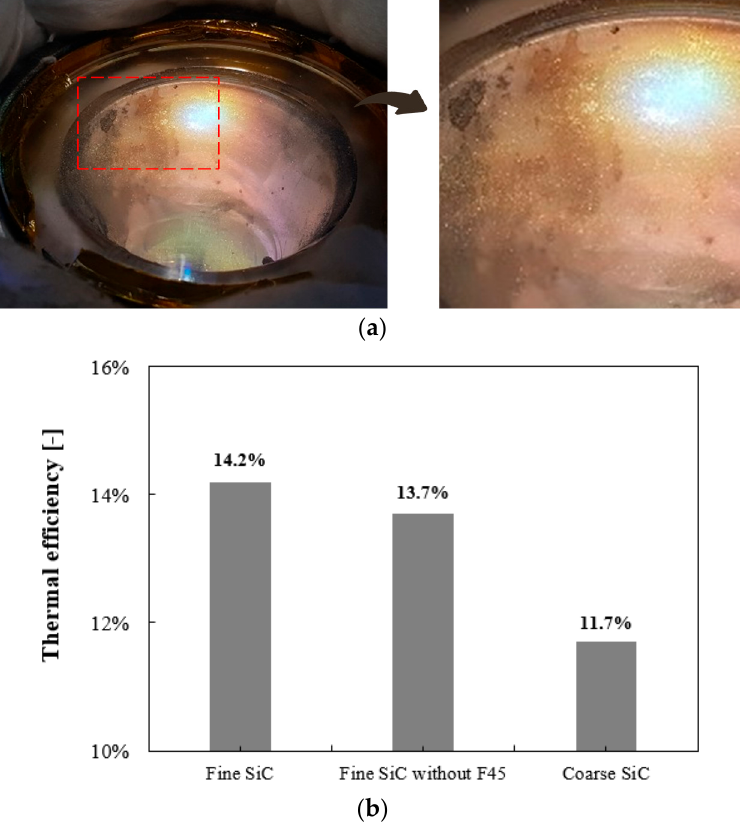
Figure 8. Effect of fine powder less than 45 μ m in bed materials on light transmissivity: ( a ) fine power stuck to window; ( b ) Effect of fine powder on thermal efficiency at U g = 0.05 m/s.